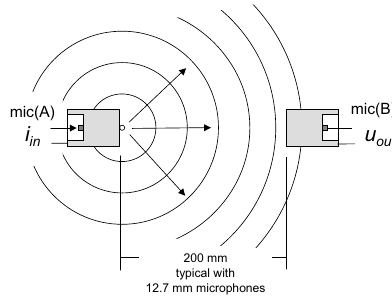
Fig. 5. Microphones coupled by air in the open space for free-field reciprocity calibration.